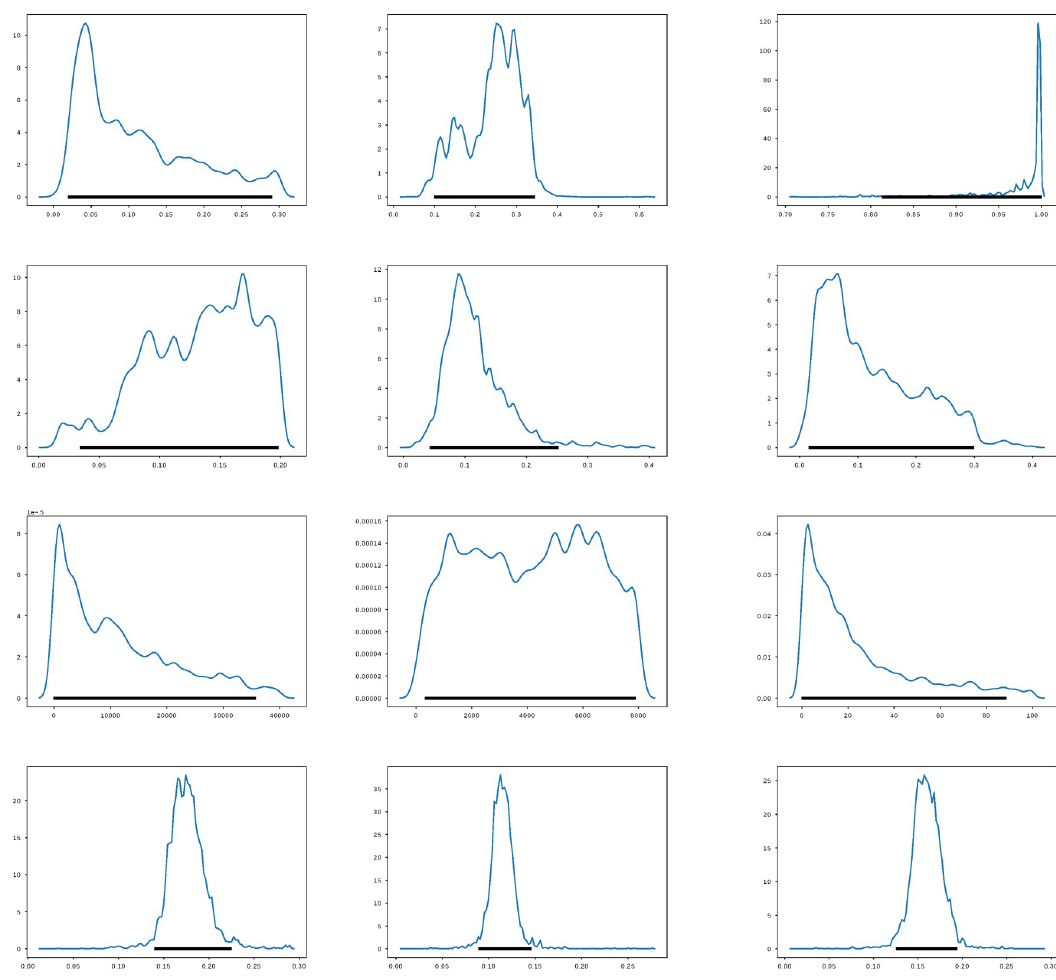
Fig 4. Credible intervals for the estimated parameters. Credible intervals for the estimated parameters of model (1) within %95 of HPD using the t- walk Package [64]. Top row from left to right, the parameters: β s , β a , ρ . Middle row from left to right: γ , σ , q . Middle row from left to right: E 0 , A 0 , I 0 . Bottom row from left to right: ϕ 0 , ϕ 1 , ϕ 2